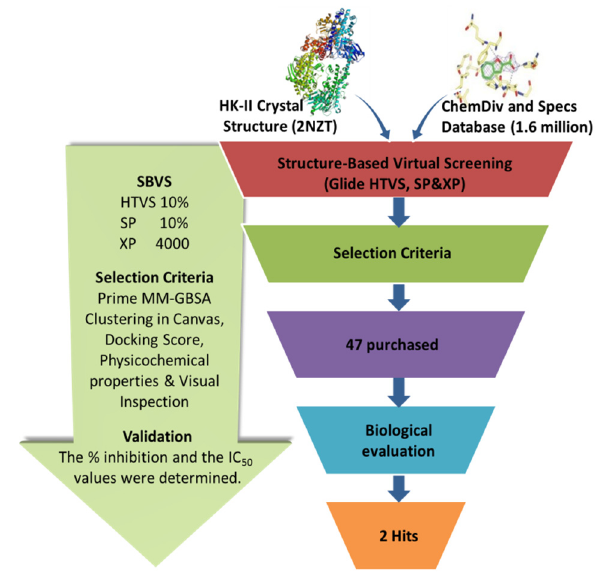
Figure 1. The virtual screening